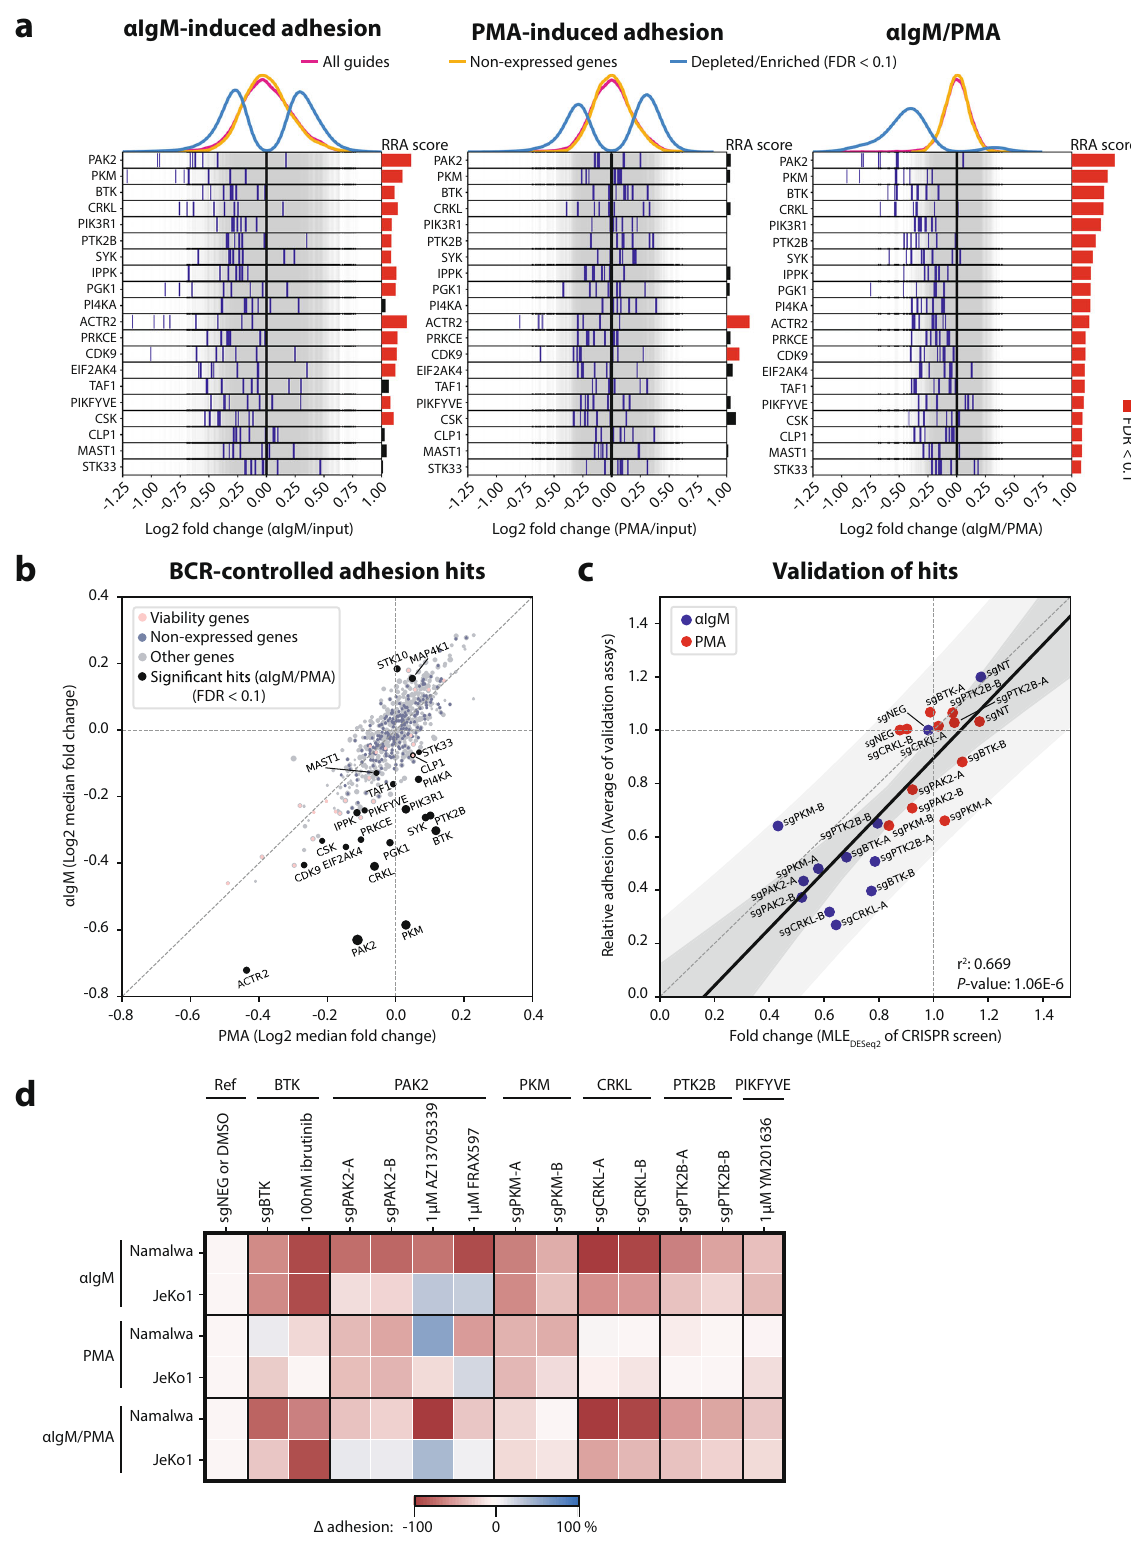
Having identi fi ed several genes involved in (proximal) BCR signaling and BCR-controlled integrin-mediated adhesion, our results provide targets for therapeutic intervention of CLL, MCL, and WM, which rely on BCR-controlled adhesion of the malig- nant cells for their retention and survival in lymphoid tissues. More speci fi cally, these targets might have clinical potential in